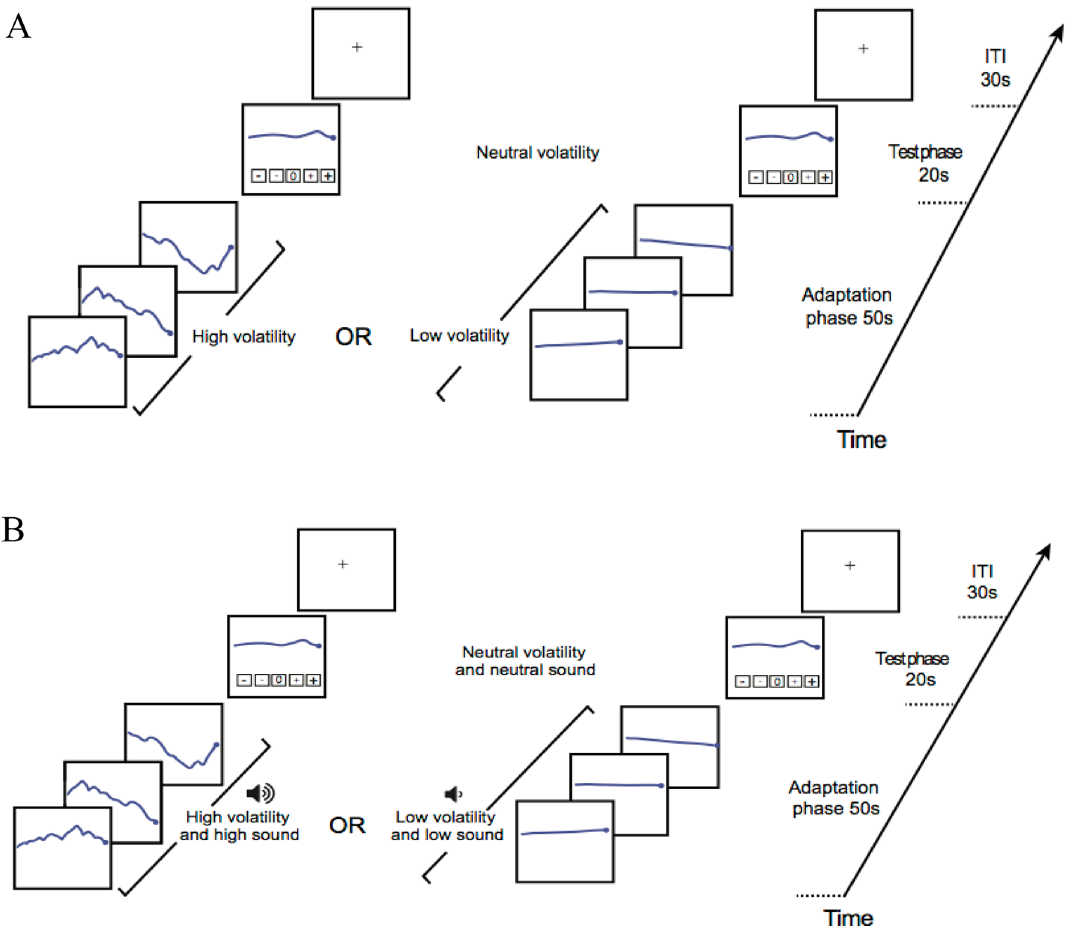
Figure 2. Timeline of an experimental trial of the task. ( A ) No sound treatment. Adaptation phase: Brownian motion depicting a financial asset with either high risk (30% volatility) or low risk (4% volatility) was displayed for 50 s. Test phase: medium (“neutral”) volatility was depicted by a 10% volatility Brownian motion displayed for 20 s, during which participants reported their perceived volatility on a 5-point scale using the mouse pointer. ITI : Inter Trial Interval. ( B ) Treatment with sound. That treatment was identical to the treatment without sound except that each volatility stimulus was paired with a congruent audio soundtrack recorded from a real-world financial